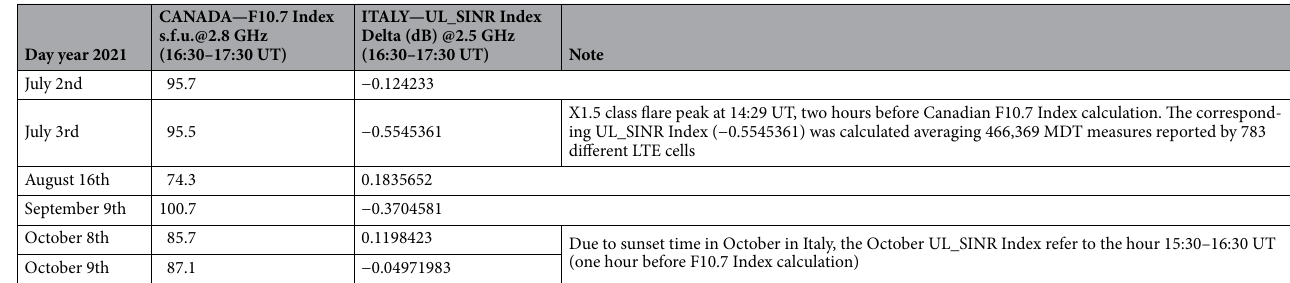
Table 1. Comparison between Canadian F10.7 Index (2.8 GHz Penticton Radio-Telescope) and UL_SINR Index (derived from MDT radiomobile measures in 2.6 GHz